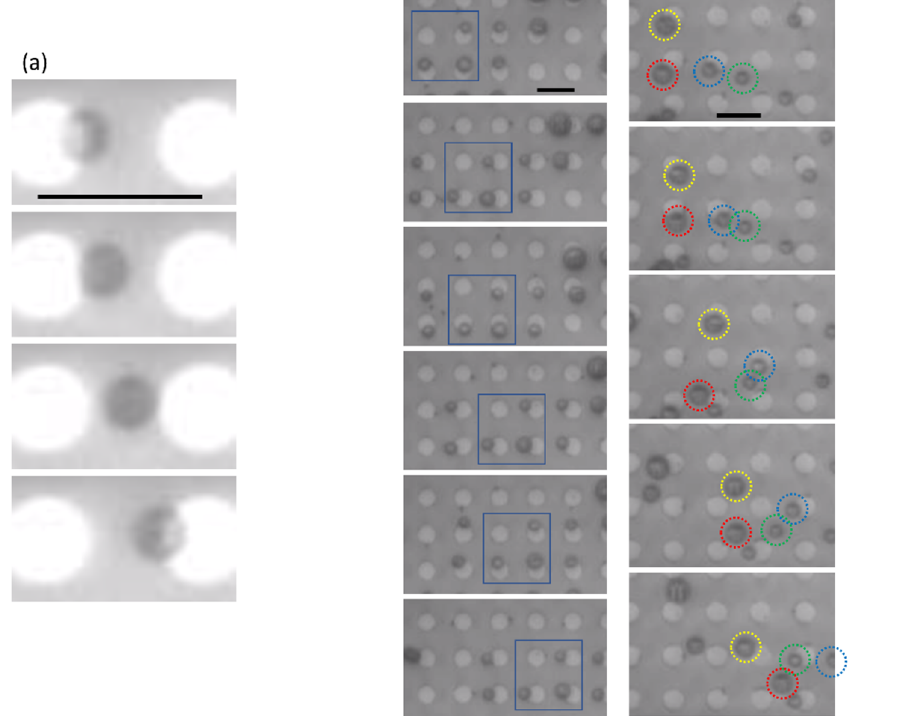
Figure 2. ( a ) Short range microparticle (dark gray) hopping from permalloy disk (white) to adjacent disk. Particle hopping is initiated by the abrupt direction switching of an out-of-plane magnetic field. ( b , c ) Particle manipulation across several disks. The mechanism by which long-range motion occurs is detailed in the materials and methods. ( b ) Low-frequency phase-locked motion using a cycling magnetic field frequency of 1.5 Hz. All particles move synchronously; an example is shown in the blue boxes. ( c ) High-frequency phase-slipping motion, where rightward motion still occurs, but the motion is not synchronous, as indicated by the particles in multicolored circles. The motion of the particles is no longer synchronous with other particles or with the field. All particles in this figure are Spherotech PMS-20-10, PMS-30-10, or PMS-40-10. Scale bar: 10 microns.